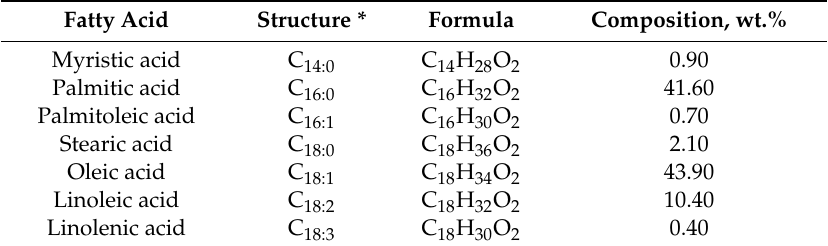
Table 1. Fatty acid composition of the palm